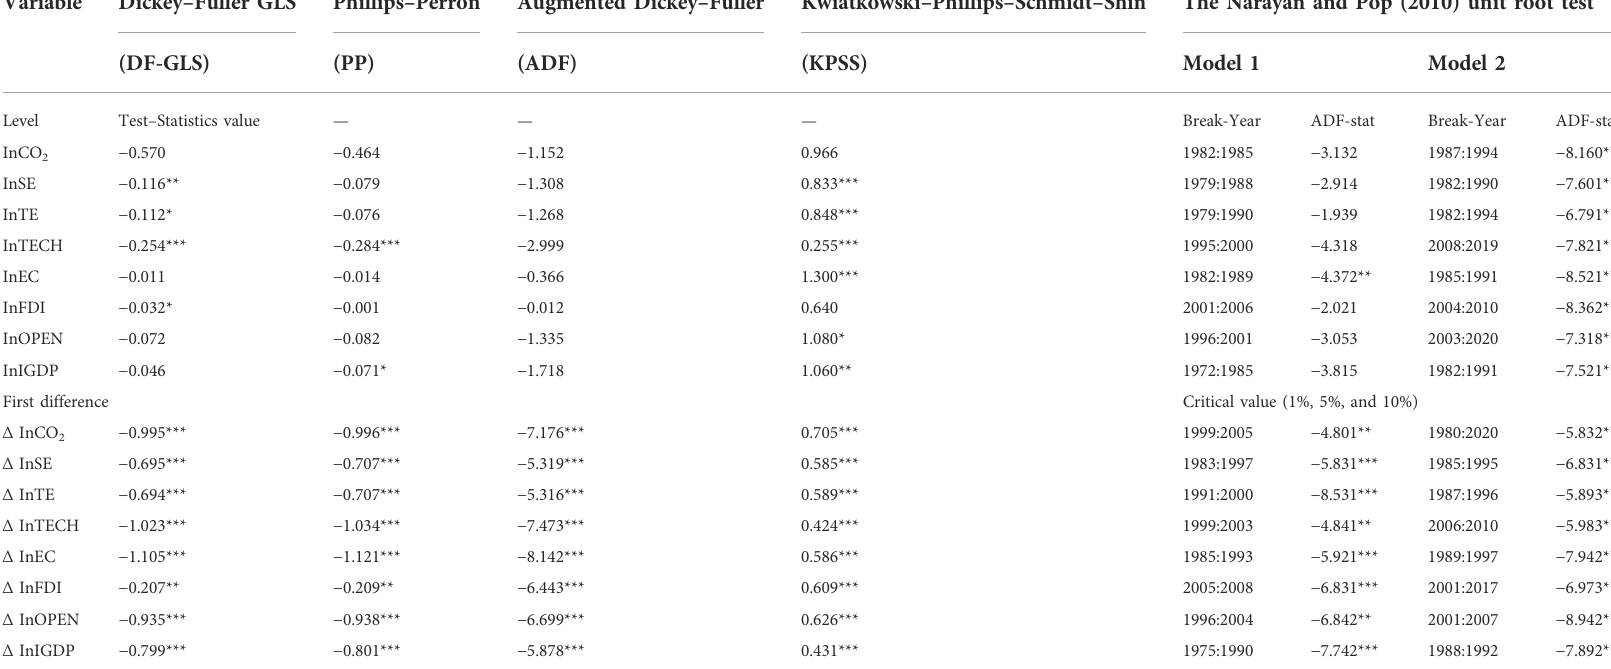
TABLE 4 Unit root